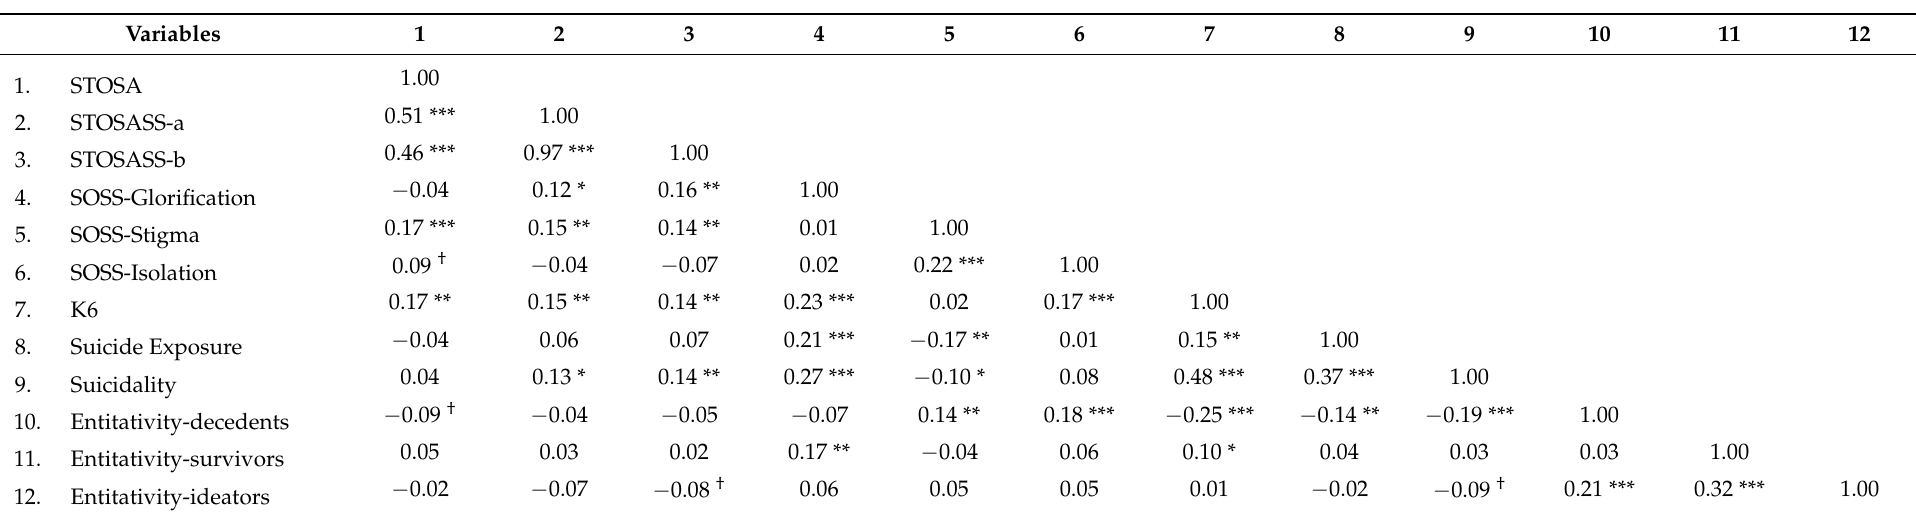
Table 3. Zero-order correlations between key variables (N = 412).